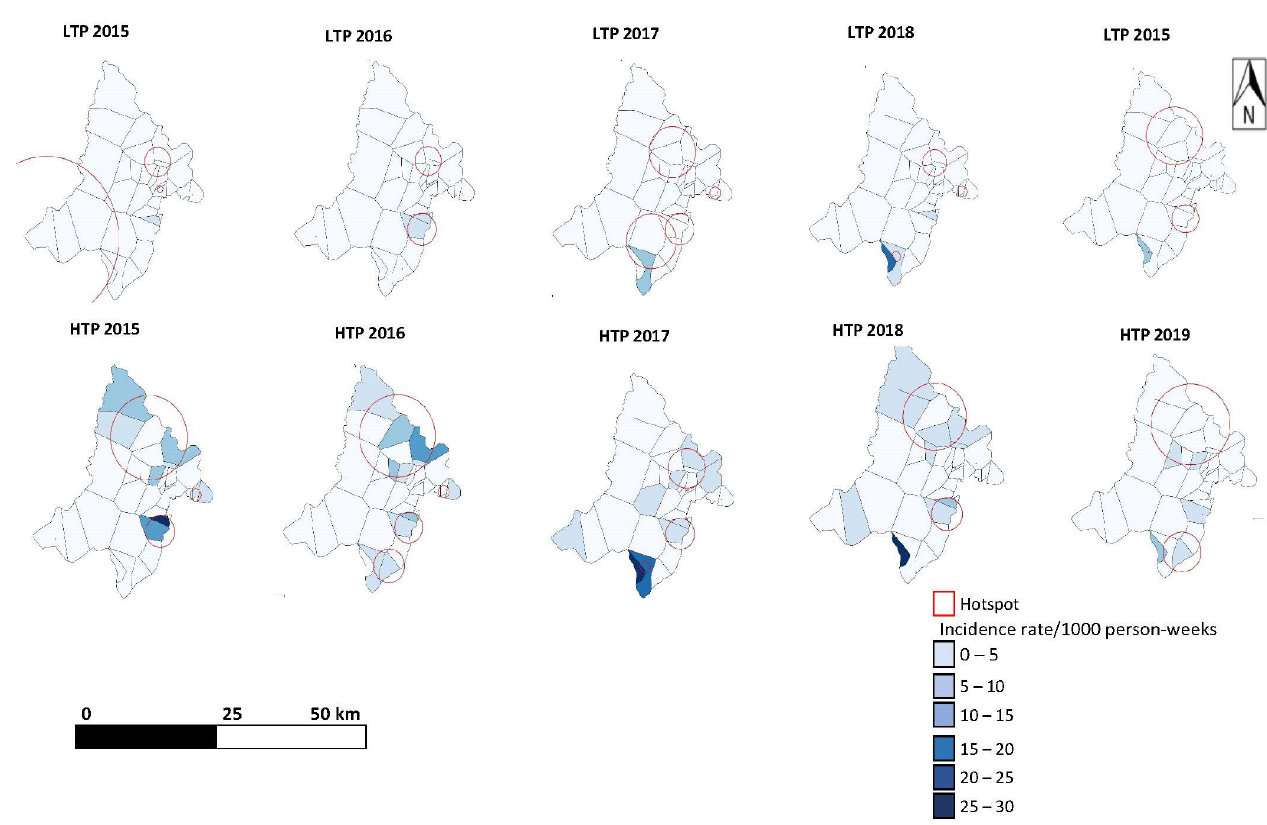
Figure 4. Maps showing the spatio-temporal distribution of malaria incidence and hotspots (red circles) in Kati health district. LTP—low transmission period; HTP—high transmission period.